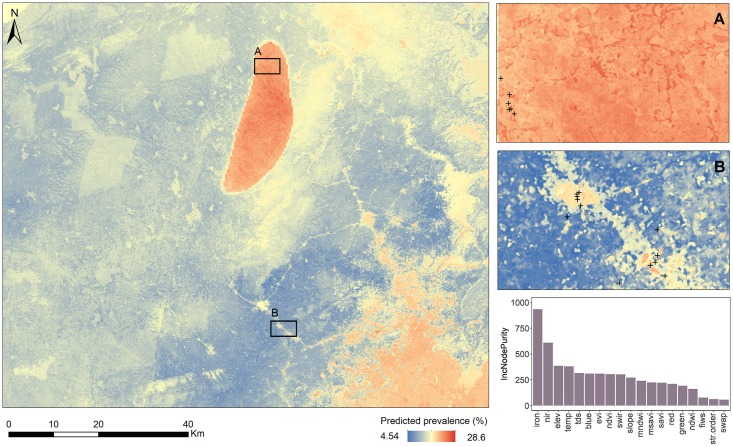
Predicted prevalence for the entire study area; for two smaller zoom windows (A and B); and variable importance values for the final model conducted with Landsat 8 environmental, topographic, and WASH variables.The scales and extents of A and B match Figs 4 and 5. Surface water access points are shown as + symbols.